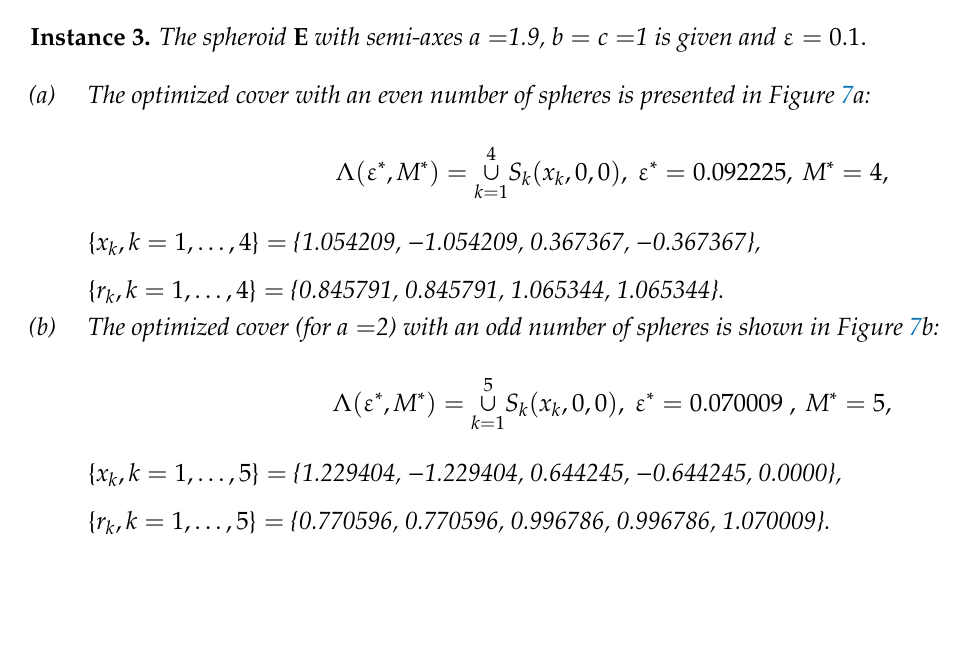
Figure 6. The optimized cover of the ellipse E: ( a ) by M ∗ = 6 circles; ( b ) by M ∗ = 7 circles.